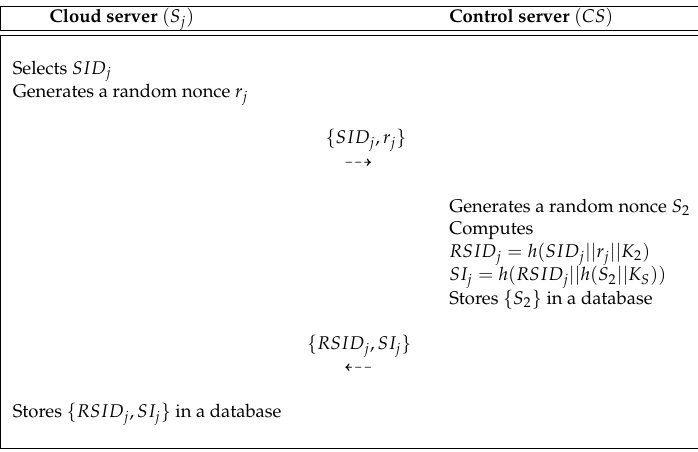
Figure 6. Cloud server registration process of the proposed